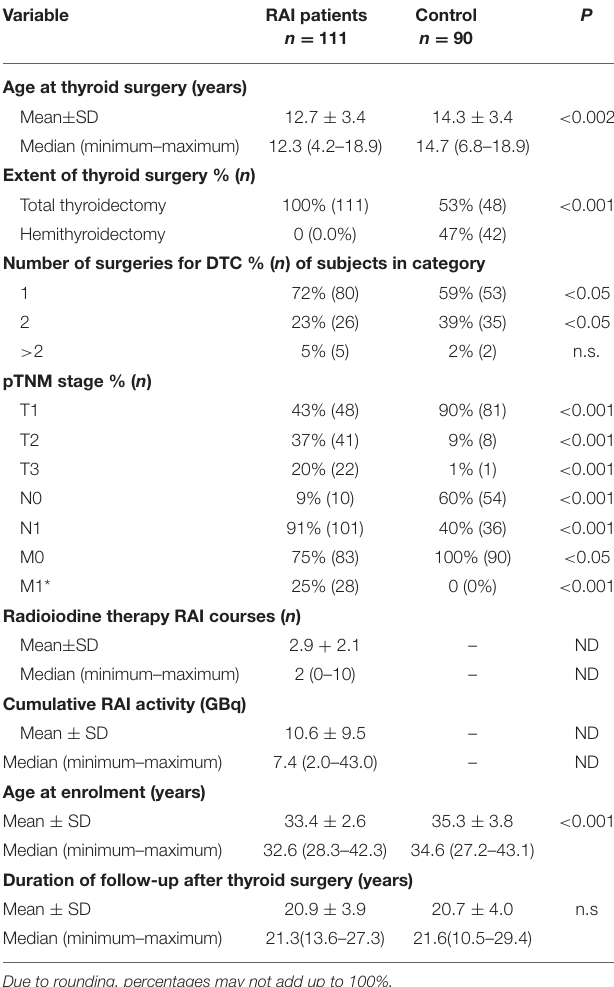
TABLE 1 | Characteristics of RAI patients and